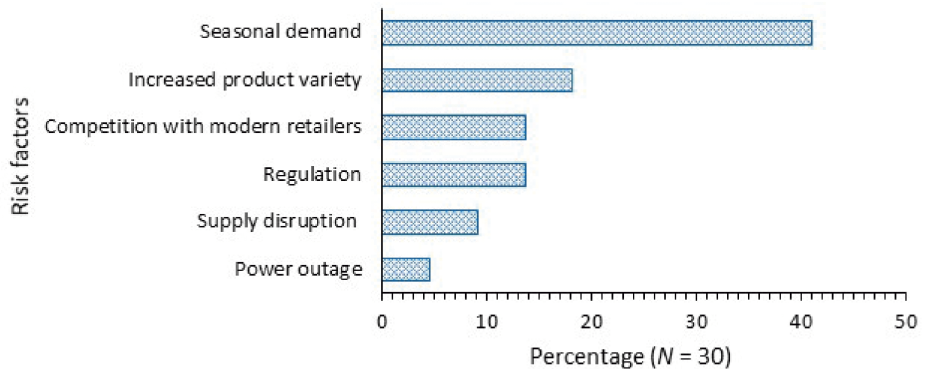
Figure 4. Risk factors before the COVID-19